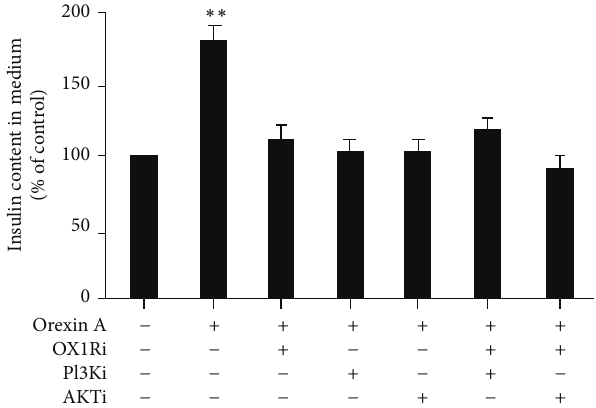
Figure 7: Effects of OXA on insulin secretion in INS-1 cells. Cells were exposed to 10 −6 M OXA in the presence or absence of PF-04691502 (AKTi) (10 −6 M), wortmannin (PI3Ki) (10 −8 M), or SB334867 (OX1Ri) (10 −6 M), or a combination of these antagonists. Insulin content was assessed via ELISA. Data are presented as mean ± SEM based on triplicate determinations from a representa- tive experiment. Asterisks indicate significant differences compared to control ( ∗∗ 𝑃 < 0.01)